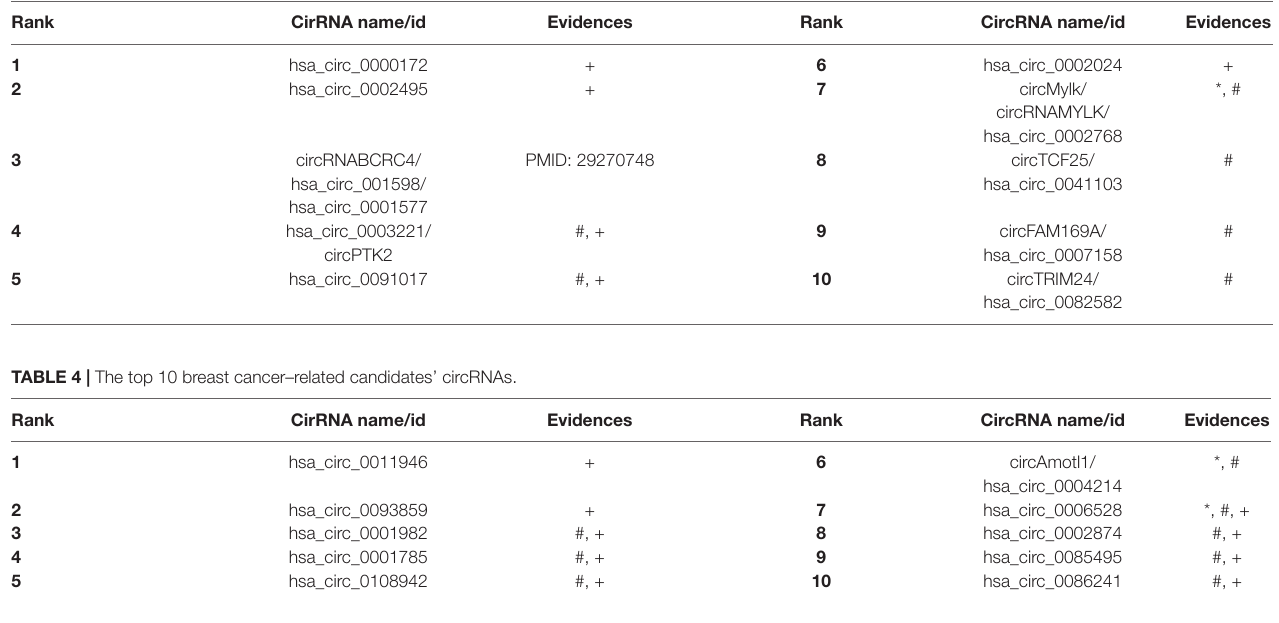
TABLE 3 | The top 10 bladder cancer related candidates’ circRNAs.